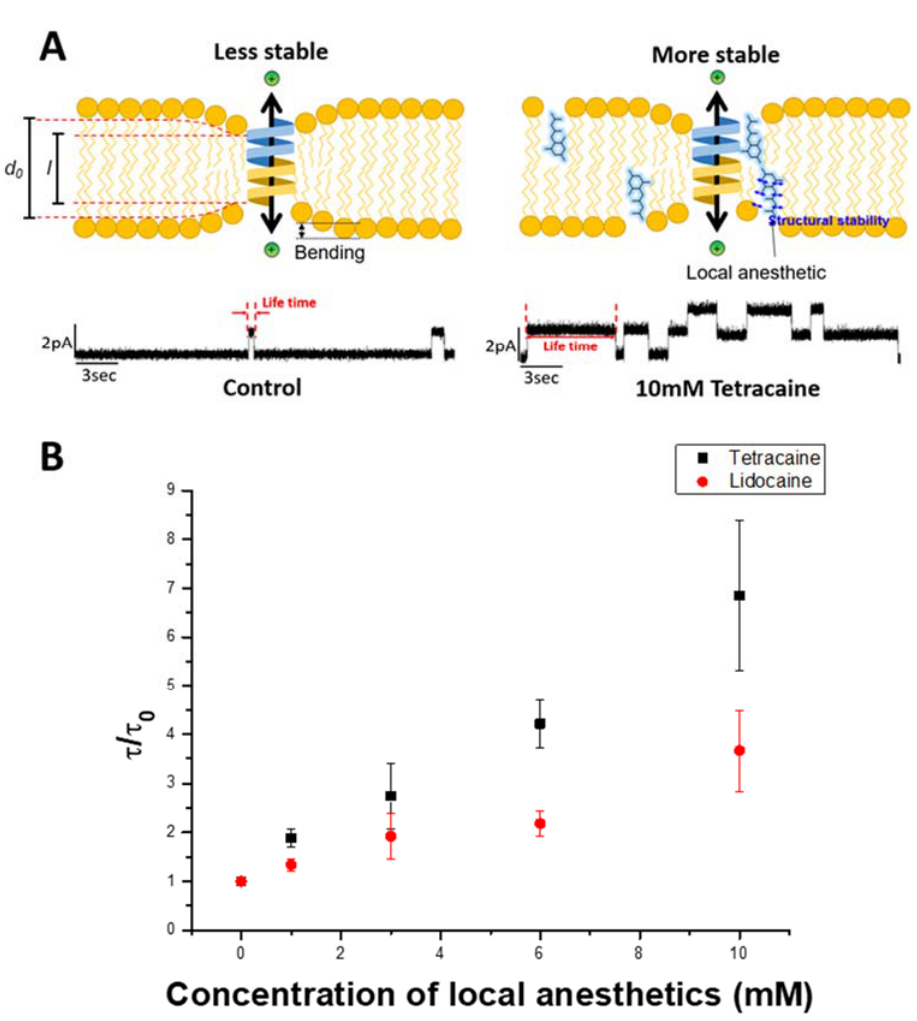
Figure 6. ( A ) The scheme of electrophysiology assay with amplifier. ( B ) Lifetime of gA (gramicidin A) dimer measurement for tetracaine (black dots) and lidocaine (red dots) for 30 min at 20 °C. Table 1. Summaries of the LAs concentration employed in IC50 and EC50 analysis, and normalized gA dimer lifetime measurement at 10 mM of LAs .